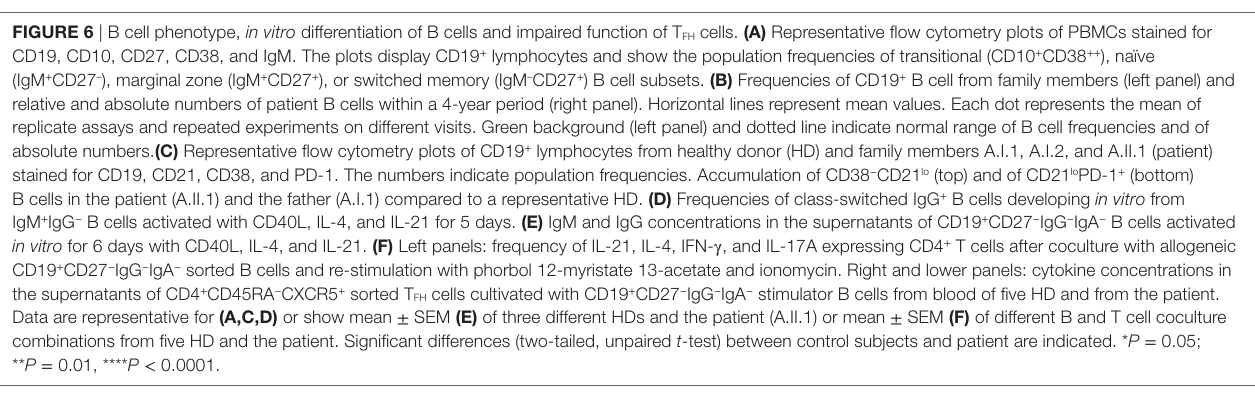
FigUre 6 | B cell phenotype, in vitro differentiation of B cells and impaired function of T FH cells. (a) Representative flow cytometry plots of PBMCs stained for CD19, CD10, CD27, CD38, and IgM. The plots display CD19 + lymphocytes and show the population frequencies of transitional (CD10 + CD38 ++ ), naïve (IgM + CD27 – ), marginal zone (IgM + CD27 + ), or switched memory (IgM – CD27 + ) B cell subsets. (b) Frequencies of CD19 + B cell from family members (left panel) and relative and absolute numbers of patient B cells within a 4-year period (right panel). Horizontal lines represent mean values. Each dot represents the mean of replicate assays and repeated experiments on different visits. Green background (left panel) and dotted line indicate normal range of B cell frequencies and of absolute numbers. (c) Representative flow cytometry plots of CD19 + lymphocytes from healthy donor (HD) and family members A.I.1, A.I.2, and A.II.1 (patient) stained for CD19, CD21, CD38, and PD-1. The numbers indicate population frequencies. Accumulation of CD38 − CD21 lo (top) and of CD21 lo PD-1 + (bottom) B cells in the patient (A.II.1) and the father (A.I.1) compared to a representative HD. (D) Frequencies of class-switched IgG + B cells developing in vitro from IgM + IgG − B cells activated with CD40L, IL-4, and IL-21 for 5 days. (e) IgM and IgG concentrations in the supernatants of CD19 + CD27 − IgG − IgA − B cells activated in vitro for 6 days with CD40L, IL-4, and IL-21. (F) Left panels: frequency of IL-21, IL-4, IFN- γ , and IL-17A expressing CD4 + T cells after coculture with allogeneic CD19 + CD27 − IgG − IgA − sorted B cells and re-stimulation with phorbol 12-myristate 13-acetate and ionomycin. Right and lower panels: cytokine concentrations in the supernatants of CD4 + CD45RA − CXCR5 + sorted T FH cells cultivated with CD19 + CD27 − IgG − IgA − stimulator B cells from blood of five HD and from the patient. Data are representative for (a,c,D) or show mean ± SEM (e) of three different HDs and the patient (A.II.1) or mean ± SEM (F) of different B and T cell coculture combinations from five HD and the patient. Significant differences (two-tailed, unpaired t -test) between control subjects and patient are indicated. * P = 0.05; ** P = 0.01, **** P <